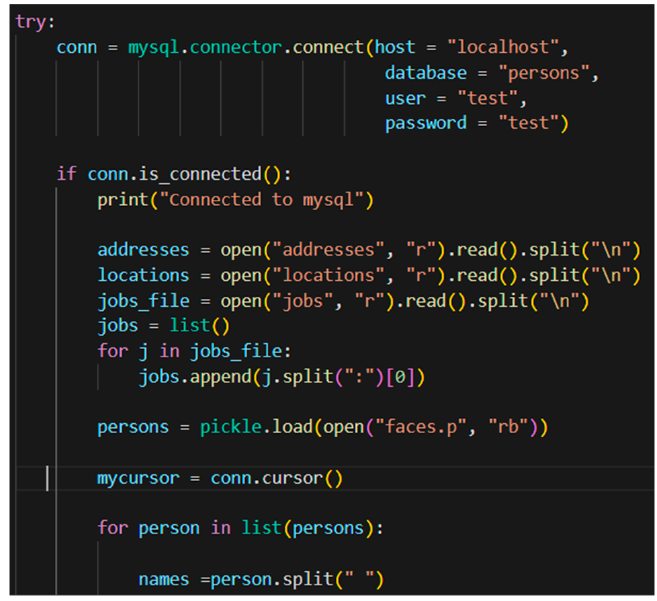
Figure 9. Partial Code of loading SQL Database File.